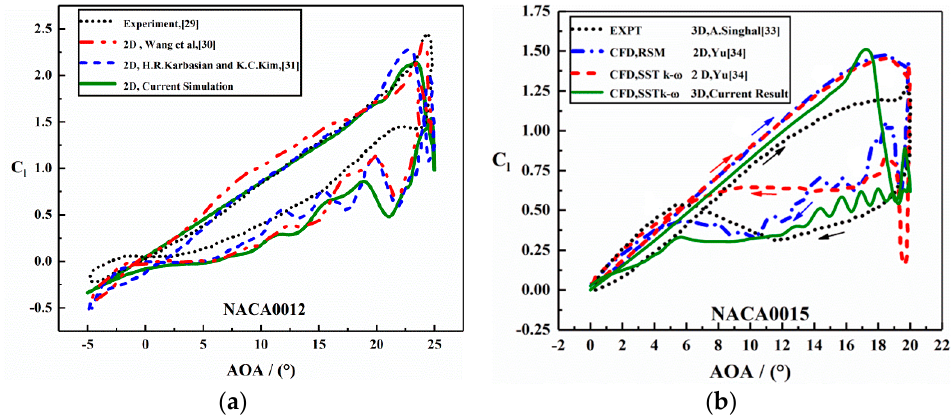
Figure 5. Comparison of current simulation with other results. ( a ) NACA0012; ( b ) NACA0015.